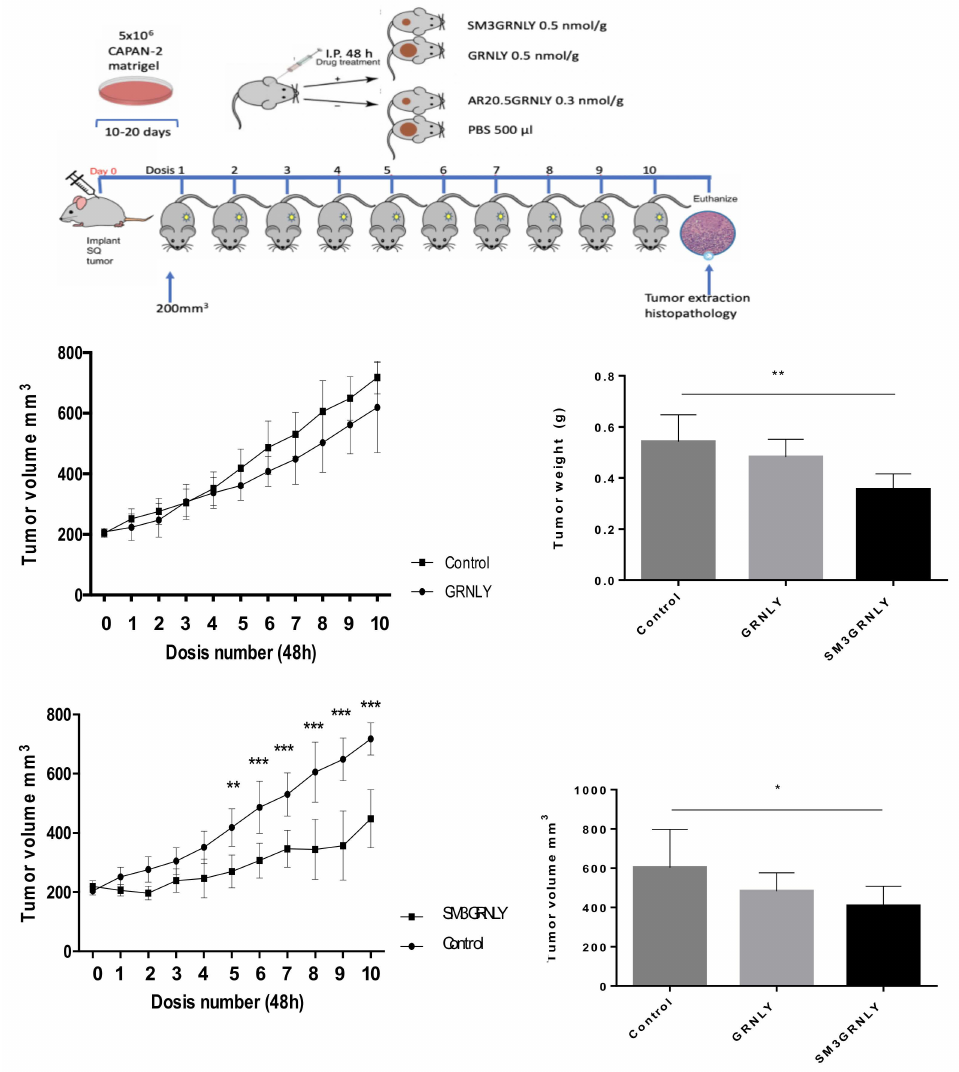
Figure 9. Systemic treatment of nude mice xenografted with CAPAN-2 cells. The mice in each group received intraperitoneal injections of GRNLY or of SM3GRNLY, as indicated, every 48 h for 10 occasions and two days after the last dose, the animals were sacrificed. Mice in the control group received PBS injections with the same schedule. Line graphics show the mean ± SD of tumor volume as a function of time in the control group and in GRNLY-treated mice (upper graphic) or in the control group and in SM3GRNLY-treated mice (lower graphic), Bar graphs correspond to the mean ± SD of the weights (upper graphic) or volumes (lower graphic) of surgically excised tumors from sacrificed mice in each experimental group, as indicated. * p < 0.05; ** p < 0.01; *** p <